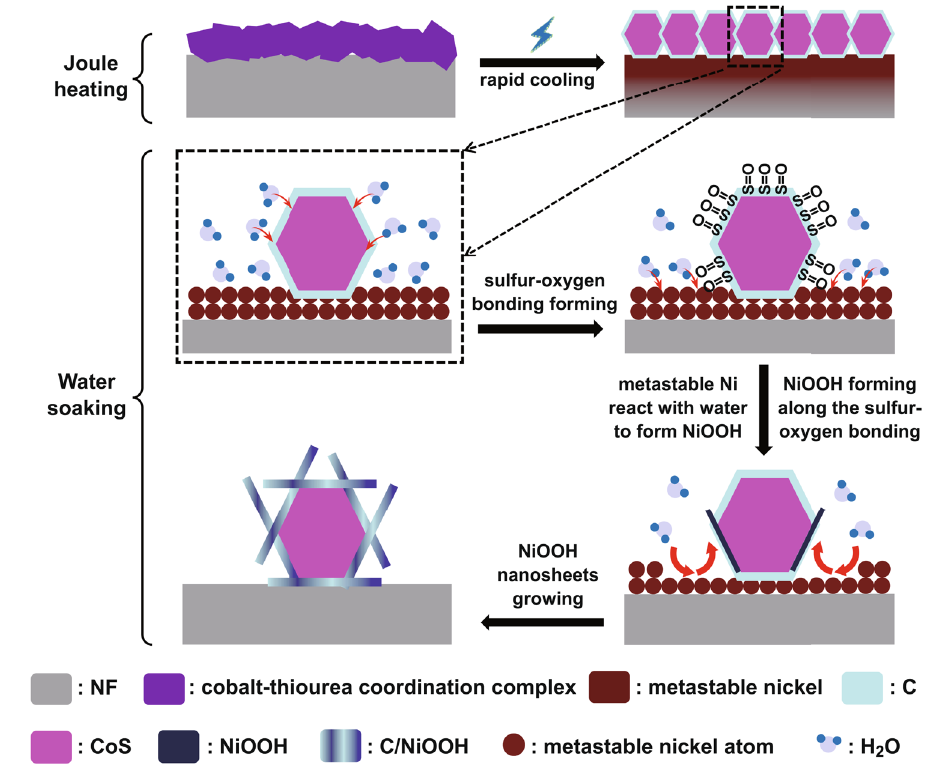
Fig. 4 Schematic diagram of the formation mechanism of